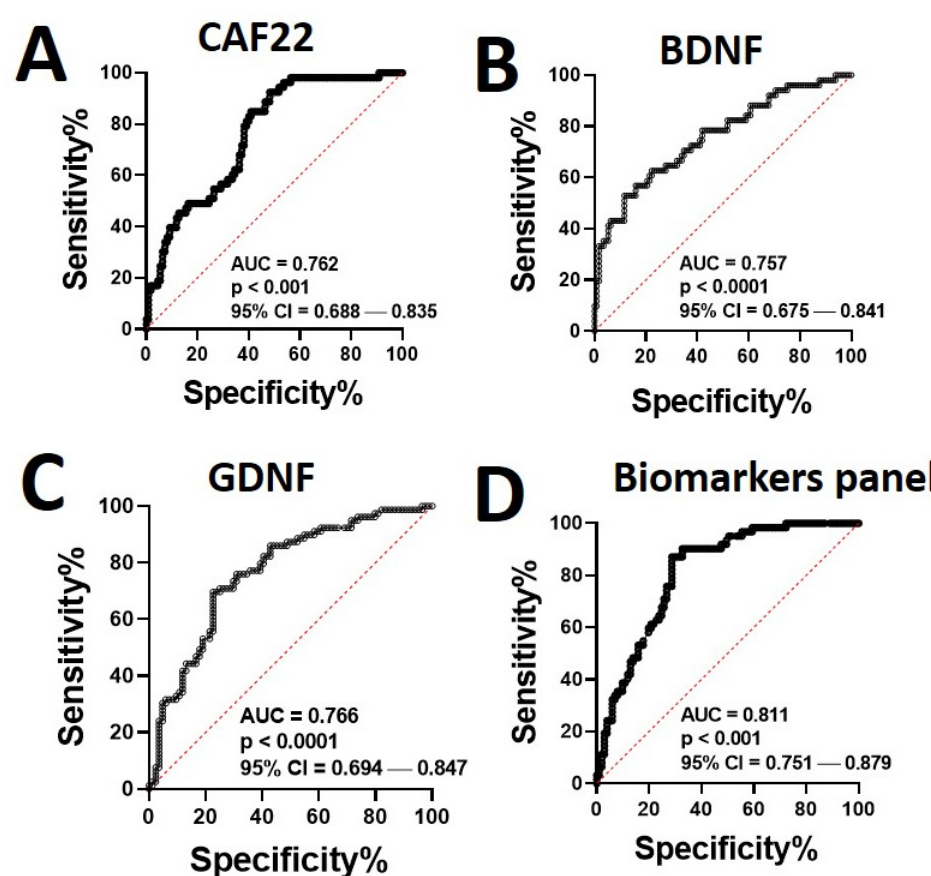
Figure 5. Significance of cumulative risk score for all the participants based on three biomarkers (CAF22, BDNF, and GDNF). Receiver operating characteristic (ROC) curves for CAF22 ( A ), BDNF ( B ), GDNF ( C ), and the biomarkers panel ( D ) in healthy controls and patients with COPD at diagnosis (Dx) and follow-up ( n = 77–84/group). The area under the curve (AUC) was calculated for each group to determine the significance of the biomarkers panel in the diagnosis of sarcopenia. Table 2. The area under the curve (AUC) and confidence intervals for individual biomarkers and the biomarkers panel in healthy controls and patients with COPD at diagnosis (Dx) and follow-up ( n = 77–84/group).